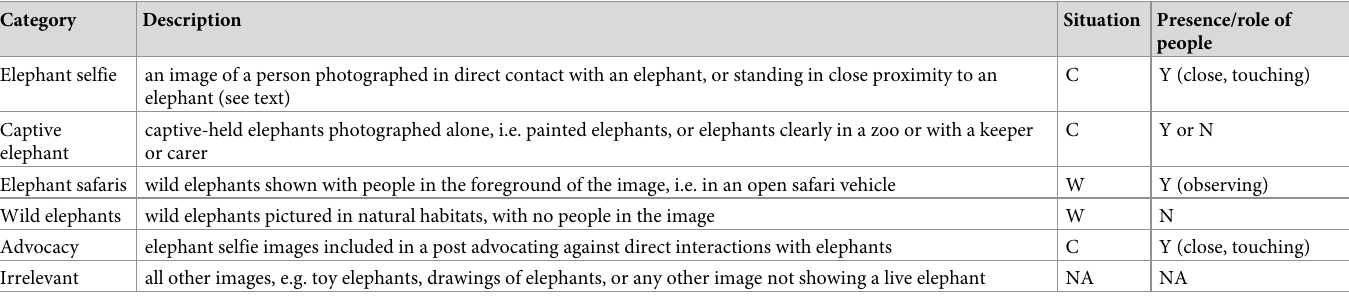
Table 1. Categories used to describe posts. ‘Situation’ refers to whether the elephant is captive (C) or wild (W); the presence of people in the image is denoted by Y (yes) or N (no), and the role of the people in the image as either ‘in close proximity to, or touching the elephant’ (close/touching) or ‘observing from a distance’ (observing). Category